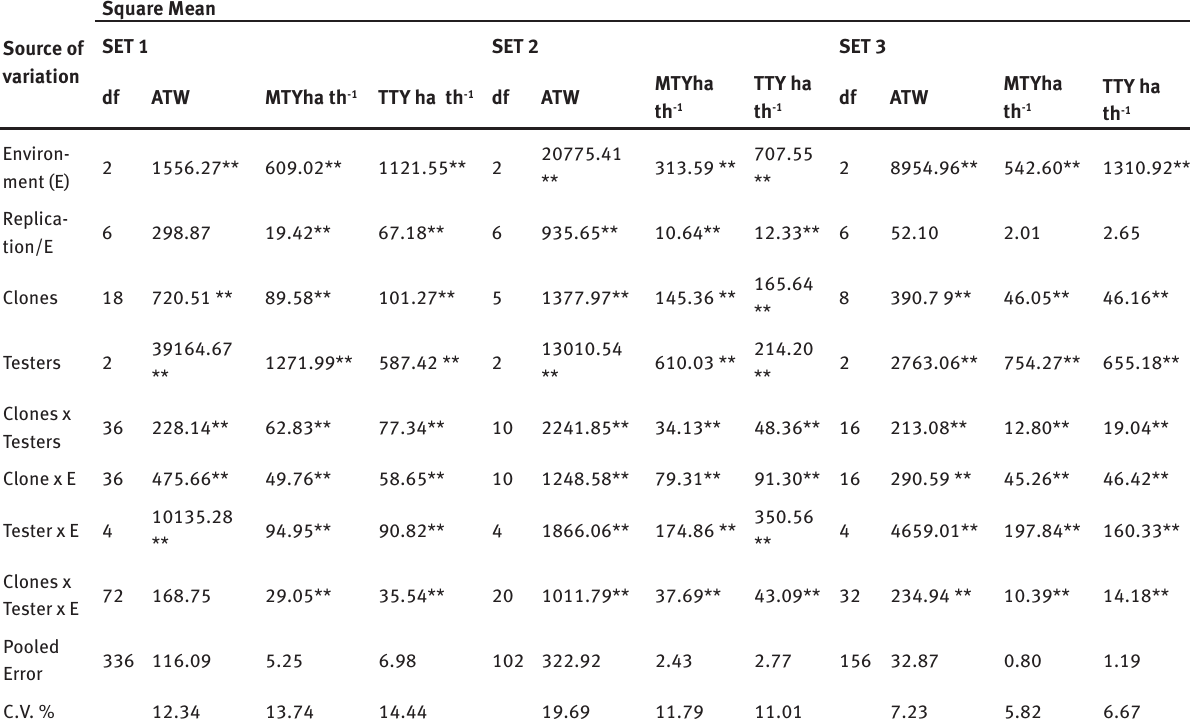
Table 5: Combined analysis of variance for average tuber weight, marketable and total tuber